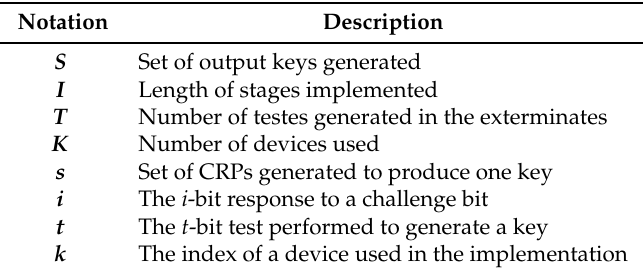
Table 1. List of Notations used in Performance